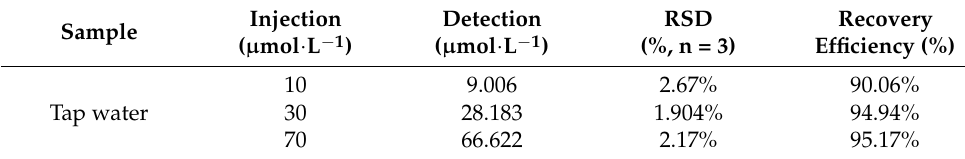
Table 2. Determination results of 4-NP in water samples and recovery